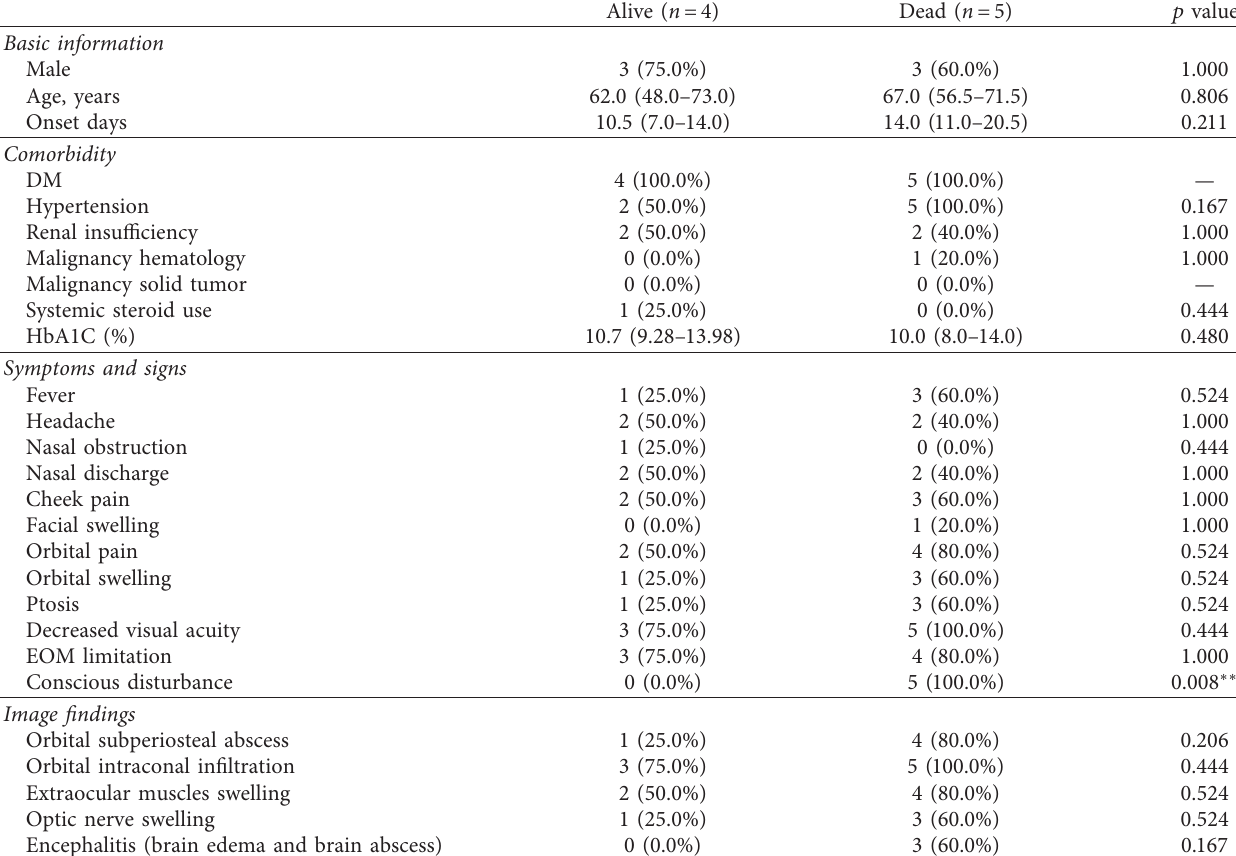
Table 2: The comorbidities, symptoms and signs, and image findings of alive or expired patients with fungal orbital infection related to AIFRS (DM: diabetes mellitus; EOM: extraocular movement).